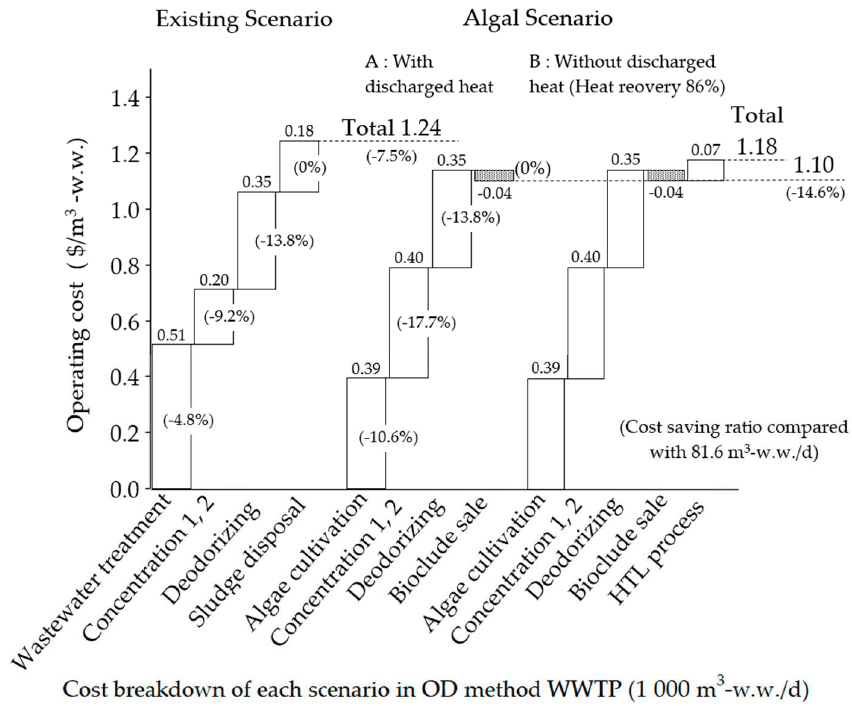
Figure 11. Operating costs ($) per 1 m 3 -w.w. for existing and microalgae oil production scenarios A and B (Treatment volume is 1000 m 3 -w.w./d).